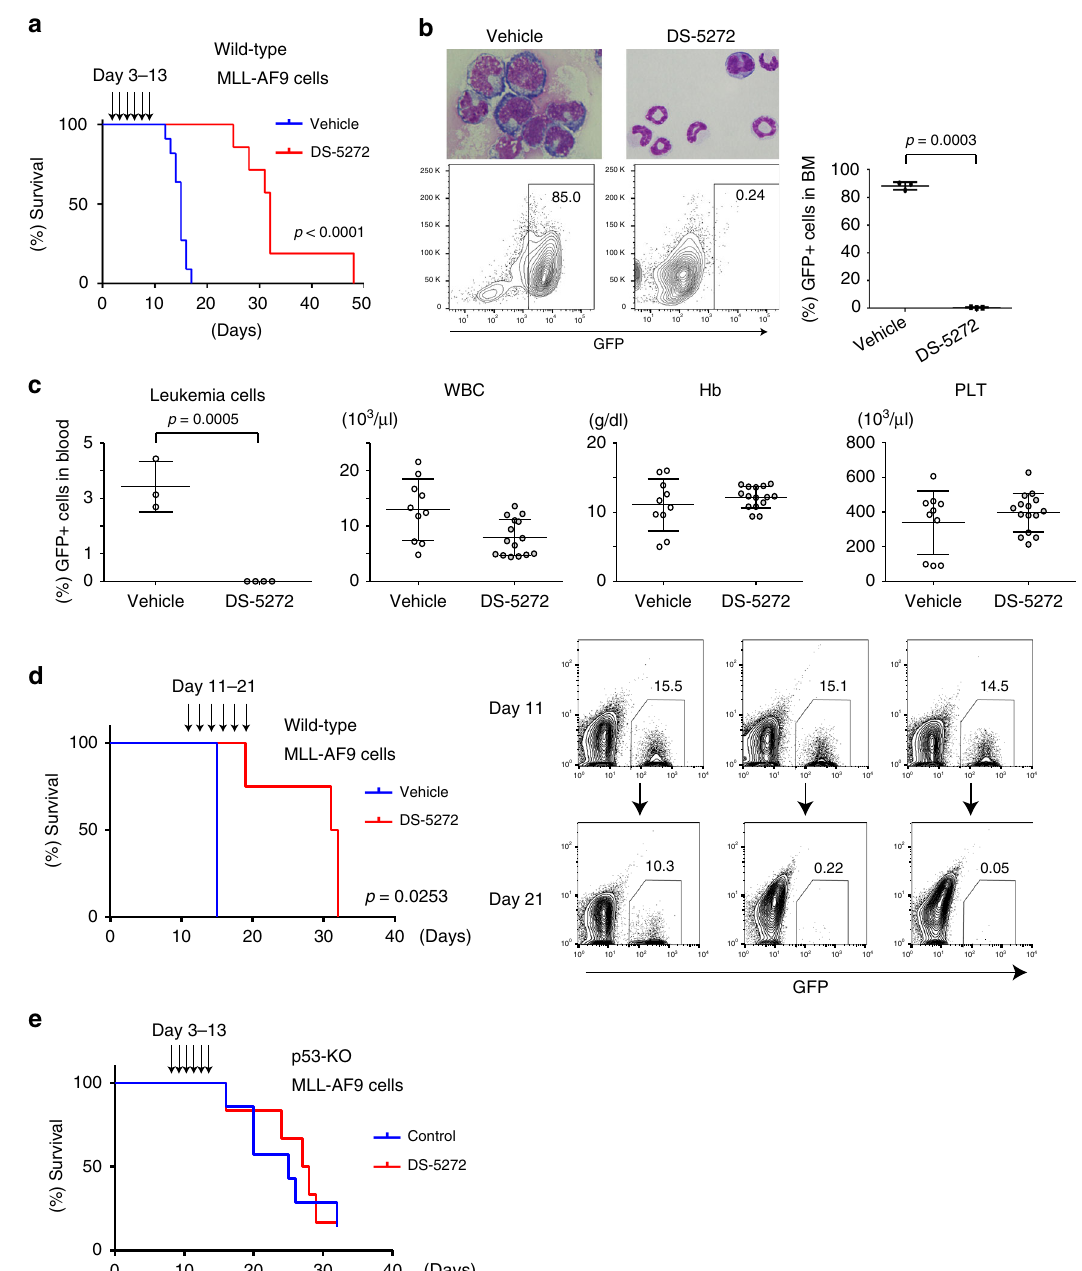
Fig. 2 DS-5272 inhibits the development of MLL-AF9-driven leukemia in vivo. a Kaplan – Meier survival curves of MLL-AF9 leukemia mice treated with vehicle or DS-5272 from day 3 to day 13. ( n = 12 per group). Statistical signi fi cance was evaluated by the log rank test. b Representative images and FACS analyses of BM cells derived from vehicle or DS-5272-treated MLL-AF9 leukemia mice (left), and the summarized data for three biologically independent experiments (right). Student t -test. c Frequency of GFP + leukemia cells in peripheral blood (Control: n = 3, DS-5272: n = 4), white blood cell counts (WBC), hemoglobin levels (Hb) and platelet counts (PLT) in leukemic mice treated with vehicle or DS-5272 at day 10. (Vehicle: n = 10, DS-5272: n = 15, data are shown as mean ± s.d.). d (left) Kaplan – Meier survival curves of MLL-AF9 leukemia mice treated with vehicle or DS-5272 from day 11 to day 21. (Control: n = 2, DS-5272: n = 4). Statistical signi fi cance was evaluated by the log rank test. (right) FACS plots of peripheral blood cells collected from MLL- AF9 leukemia mice at day 11 and day 21, showing reduction of GFP + leukemia cells at day 21 in the DS-5272-treated mice. e Kaplan – Meier survival curves of mice injected with p53-de fi cient MLL-AF9 cells, that were treated with vehicle or DS-5272 from day 3 to day 13. (Control: n = 7, DS-5272: n = 6) suggest that pharmacological activation of p53 provokes in fl am- matory and immune responses in MLL-AF9 cells, including activation of Hif1a-PD-L1 pathway. Therapy-resistant cells are enriched in BM endosteal region .